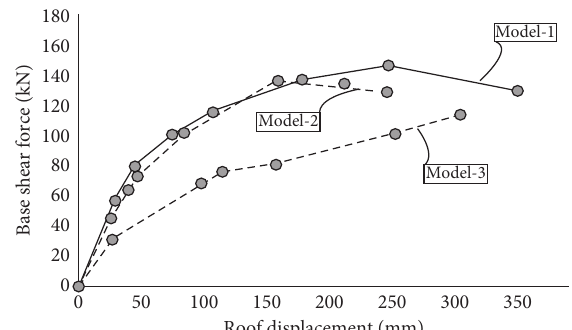
Figure 7: Developed prototype frame force-deformation relationships.